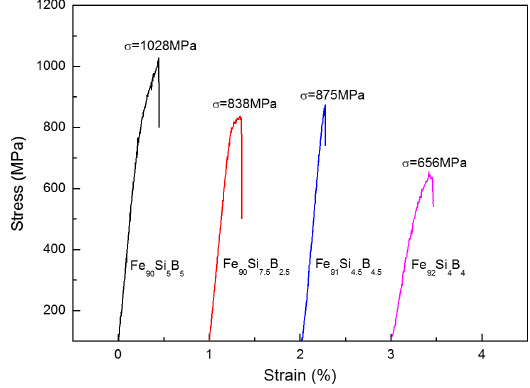
Figure 6. Tensile curve of the ductile Fe-Si-B ribbon alloys with a strain rate of 0.04s –1